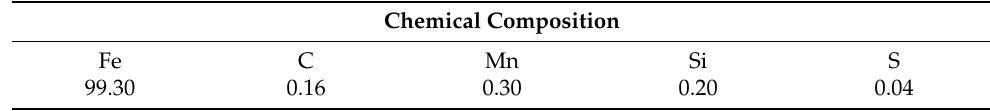
Table 1. Chemical composition of the U-shaped ring (wt.%).